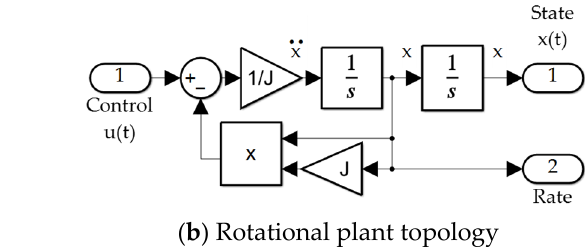
Figure 2. SIMULINK simulation program topologies used to generate the results in Section 3: ( a ) Overall system topology used to simultaneously produce state and rate estimates integrated with noisy sensors and additionally optimal control calculations; ( b ) Euler’s moment from Equation (1) elaborated in [5 − 12] describing rotational motion (notice the nonlinear coupled motion).